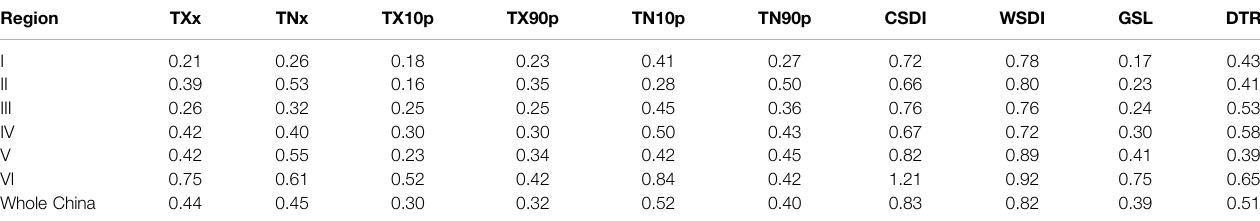
TABLE 5 | DISO for extreme temperature indices over China. Region